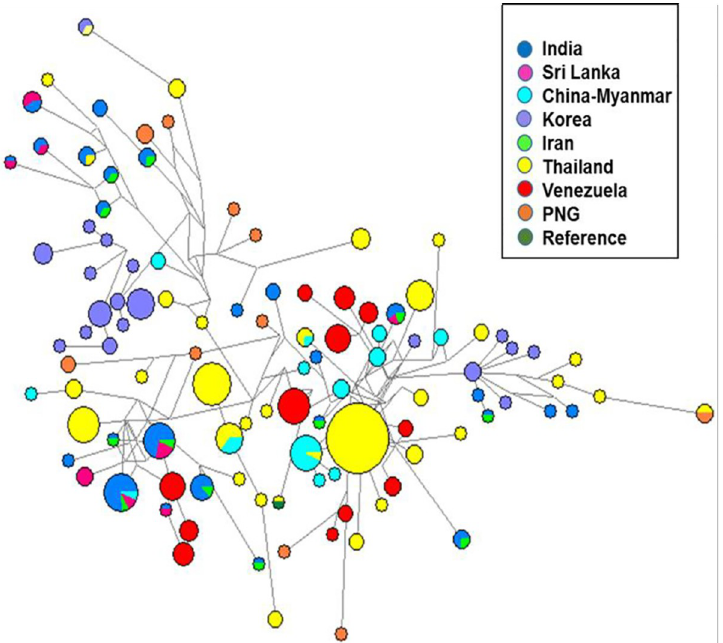
Fig 5. Median-joining network of Pvama1 between eight geographically diverse populations. Haplotypes composed of nucleotide polymorphism in Pvama1 ectodomain with a frequency > 1 were used to create a median- joining network. This network represents the mutational paths connecting Pvama1 haplotypes that may explain the observed sequence diversity. Each node represents one haplotype, node size indicates haplotype frequency and node color corresponds to the country of origin. Line length is proportional to genetic